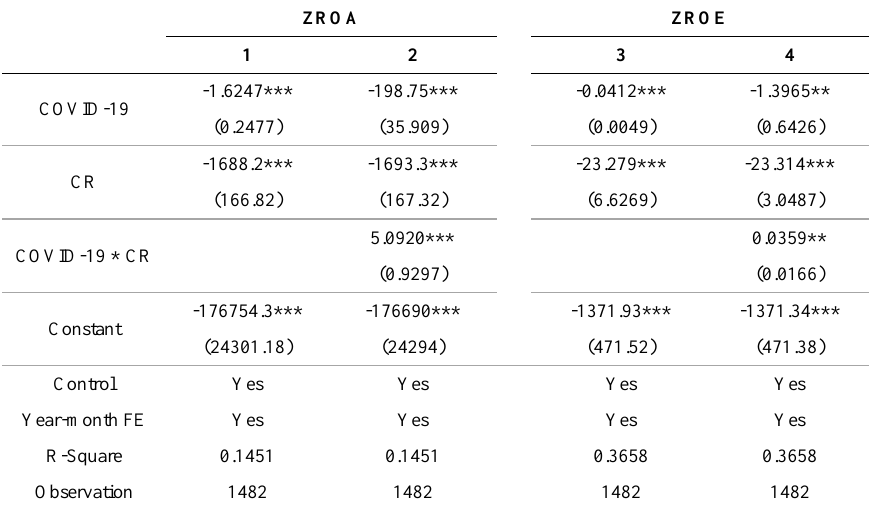
Table 7. Robustness Tests; Alternative Measures of Bank